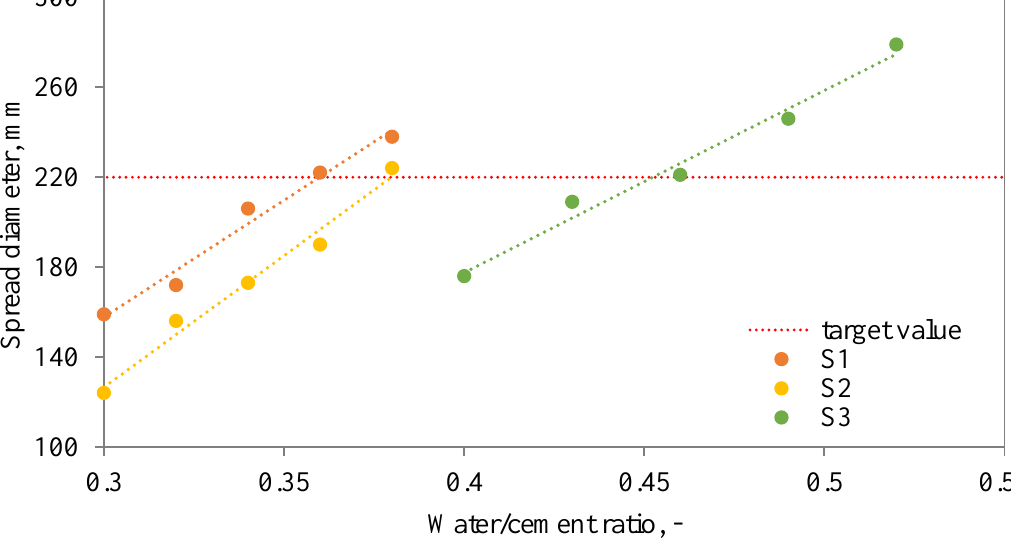
Figure 7. Dependency between spread diameter and additional water dosage for S mixtures.